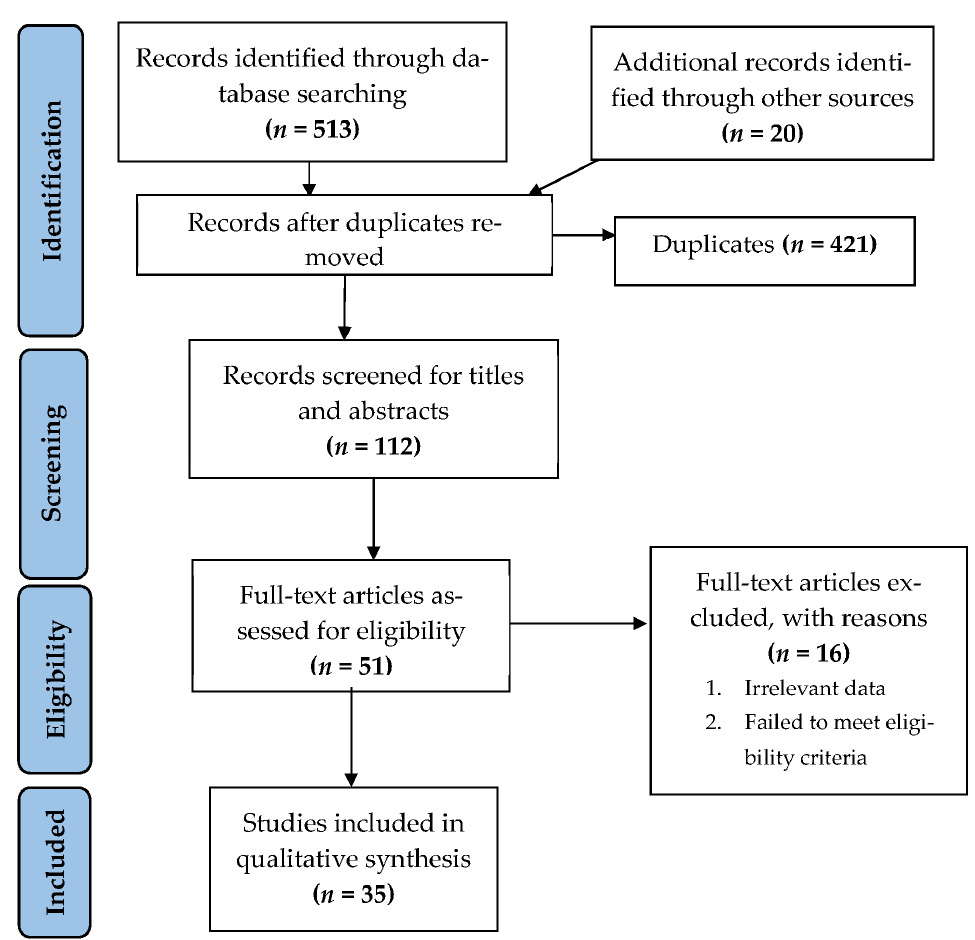
Figure 1. Flowchart summarizing the article selection process ( n —number of studies).